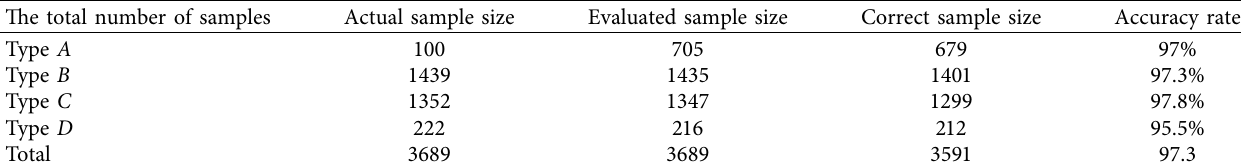
Table 2: Learning behavior assessment test